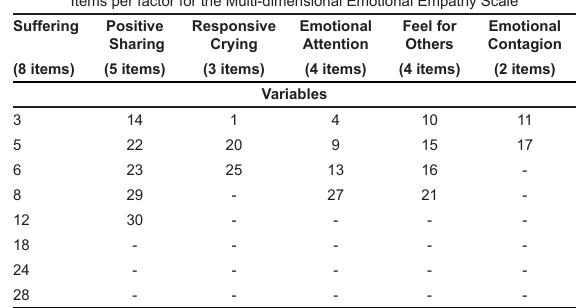
TABLE 2 Items per factor for the Multi-dimensional Emotional Empathy